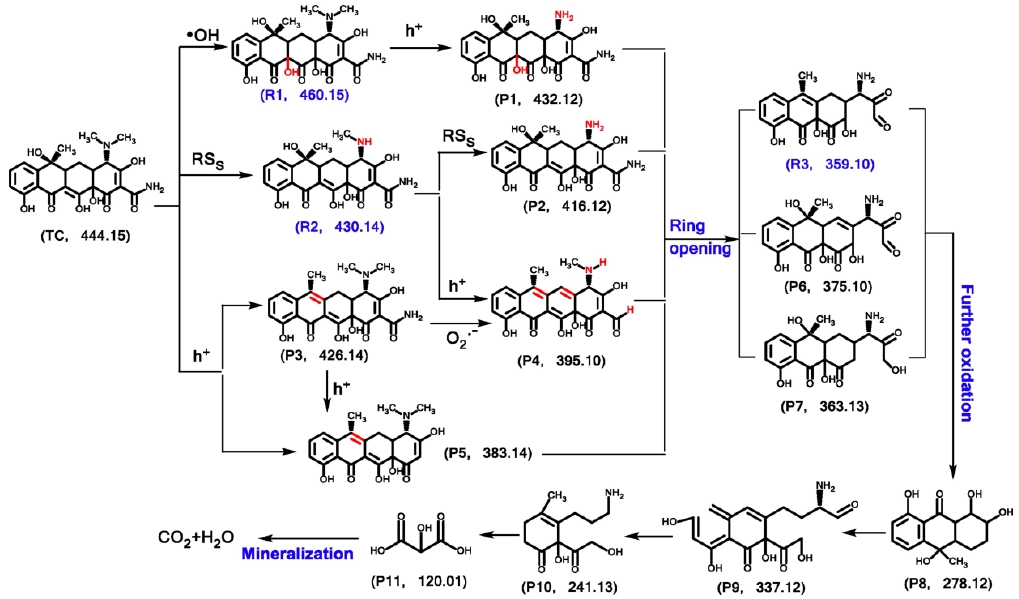
Figure 12. The proposed degradation pathway and intermediates of tetracycline [100].